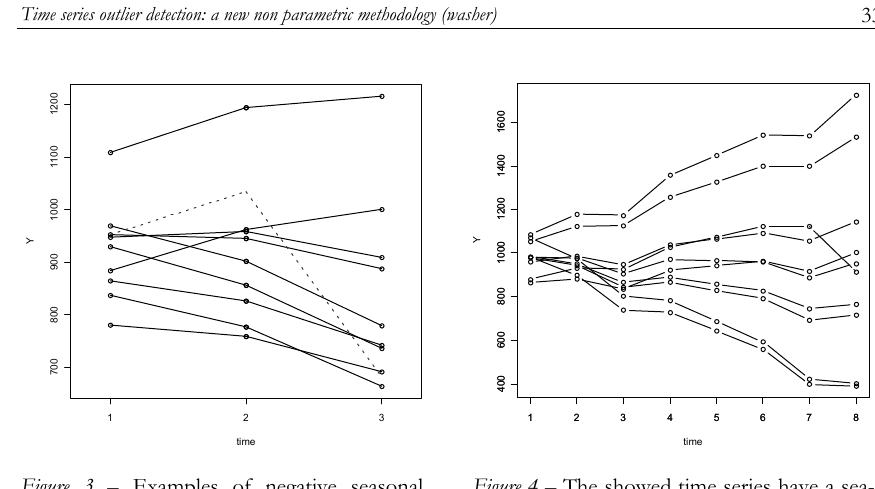
Figure 3 – Examples of negative seasonal component at t =3.